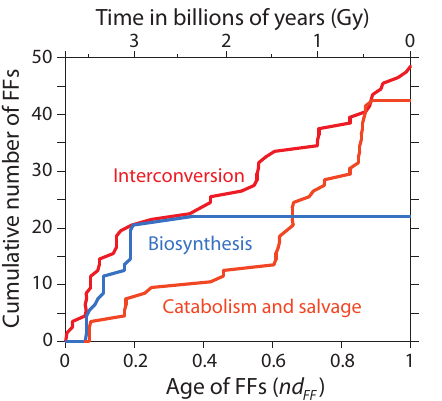
Figure 2. Evolutionary accumulation of protein domains at FF level of structural abstraction in the central pathways of purine metabolism.